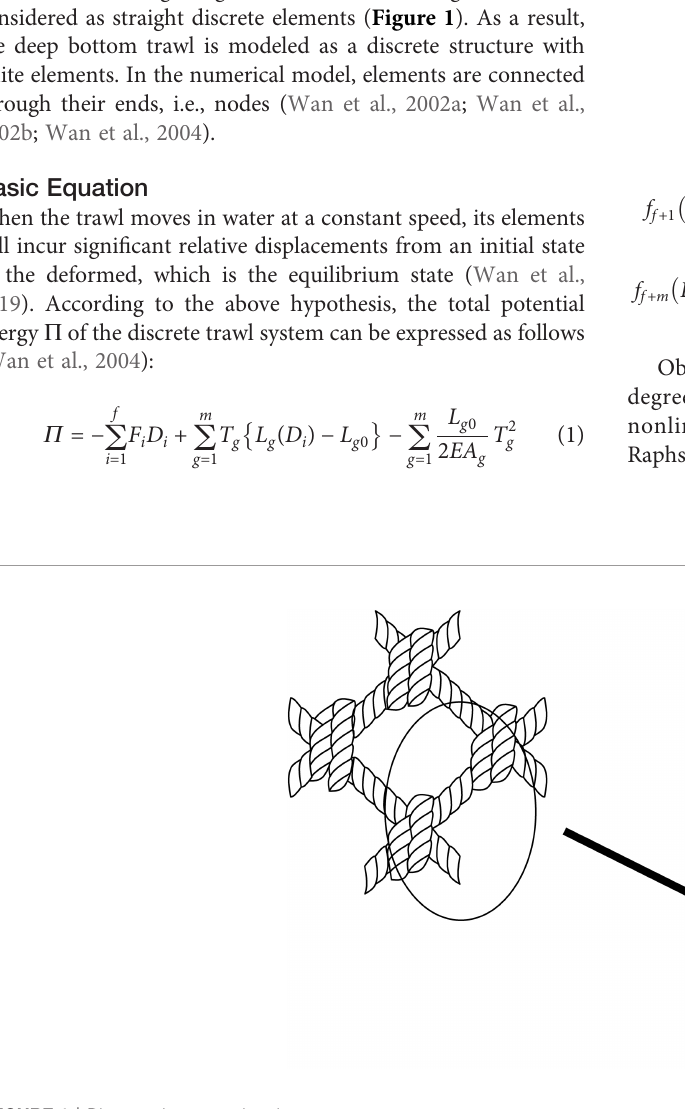
FIGURE 1 | Discrete element and